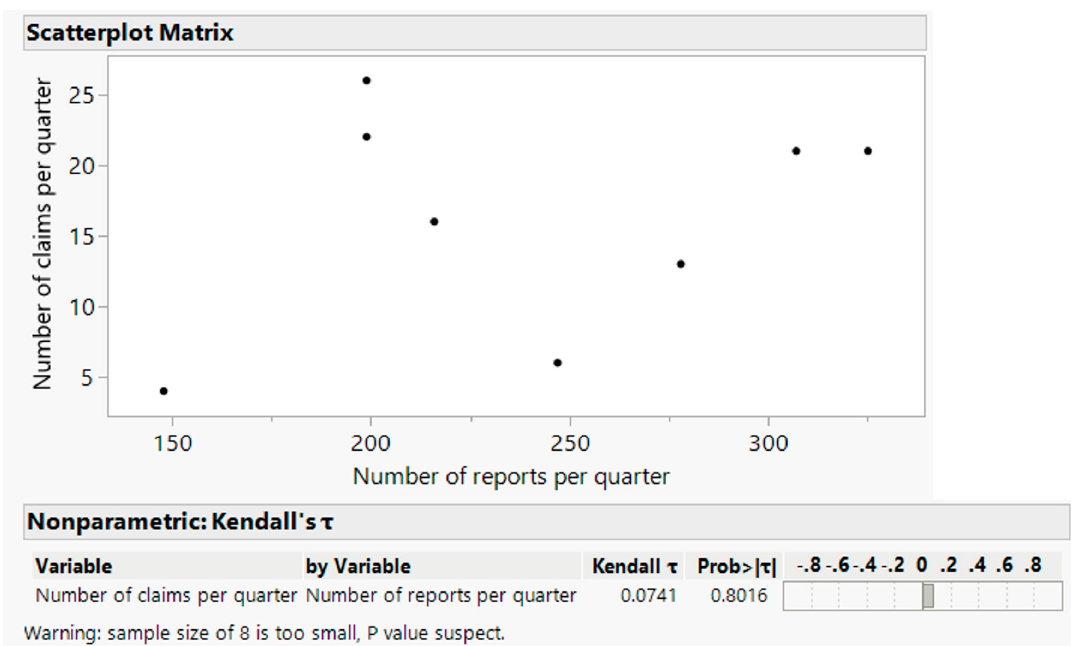
Figure 5. Kendall rank correlation.